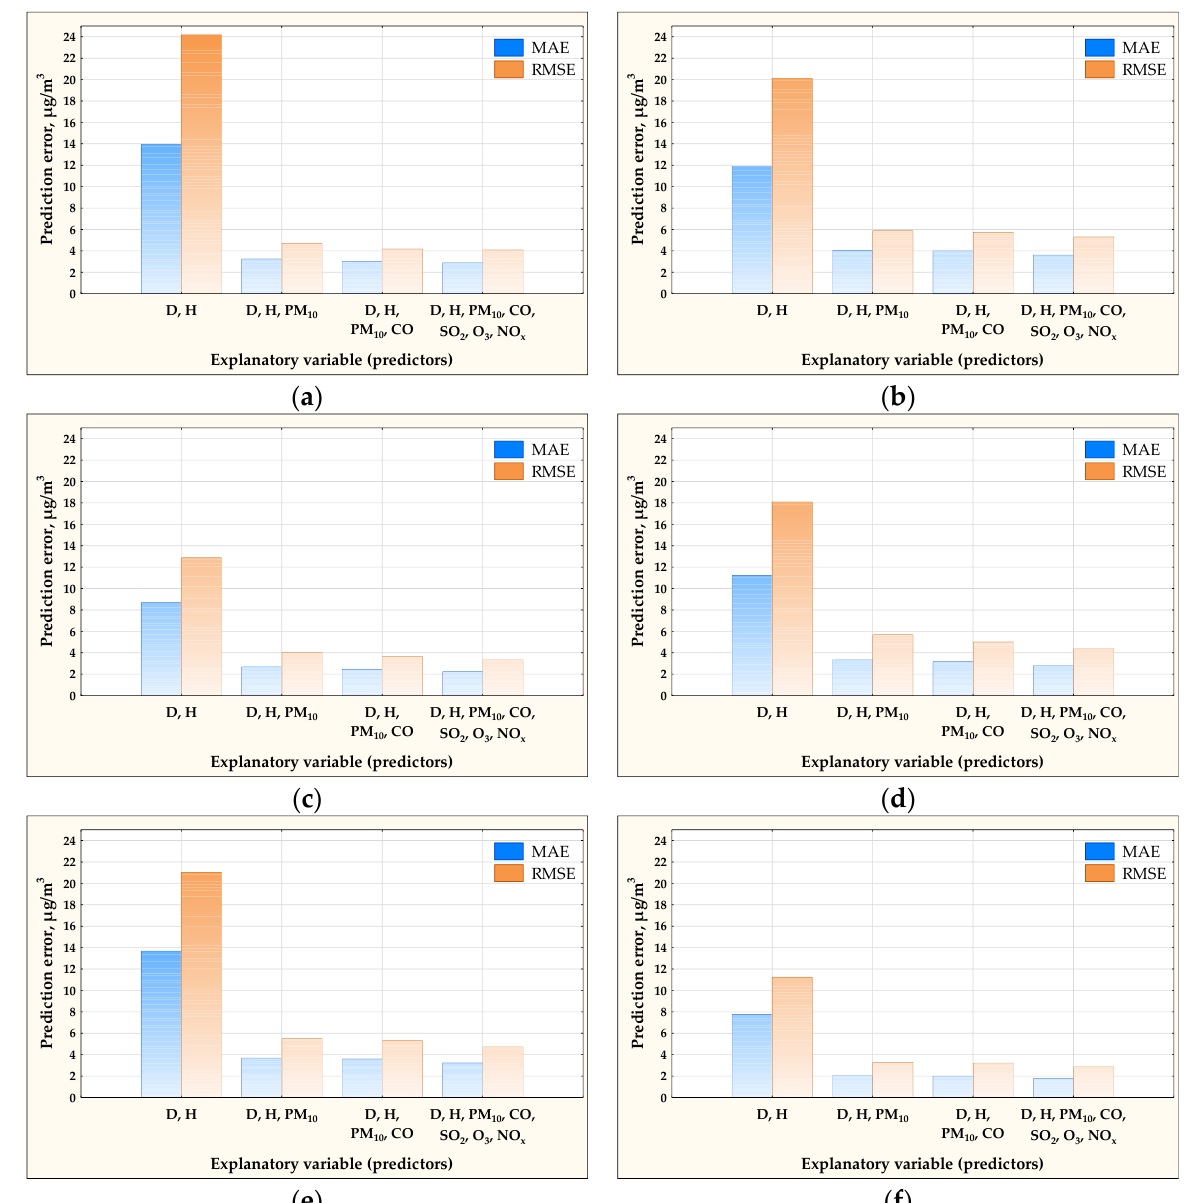
Figure 6. MAE and RMSE values for PM 2.5 concentration prediction by means of MLP neural network models depending on the predictors used (variants I, II, III, and IV): ( a ) Jelenia Gora, ( b ) Lublin, ( c ) Plock, ( d ) Radom, ( e ) Kedzierzyn-Kozle, and ( f ) Olsztyn air monitoring stations. Scatterplots were used to compare the modeled and observed values of PM 2.5 concentrations at individual automatic air monitoring stations (Figure 7). The results were shown for the most accurate models, with seven explanatory variables (variant IV: MLP 7-10-1). The scatterplots also showed perfect fit lines (blue lines: y = x) and regression lines (red lines). Linear regression equations and determination coefficients were also calcu- lated.